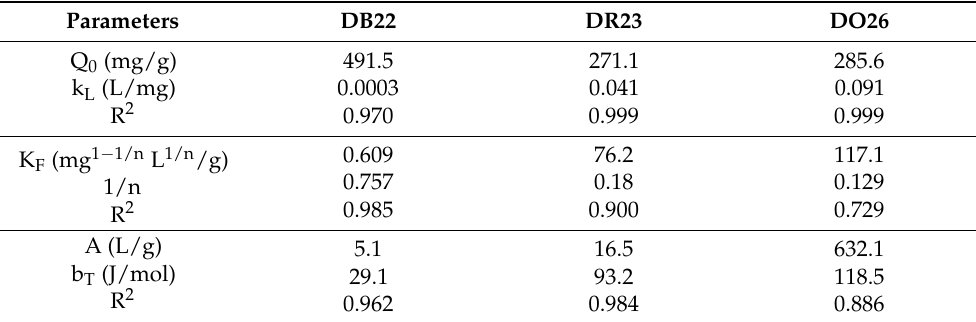
Table 2. Isotherm parameters determined from the Langmuir, Freundlich and Temkin models calculated for the adsorption of DB22, DR23 and DO26 on A21 resin at room temperature using linear regression.